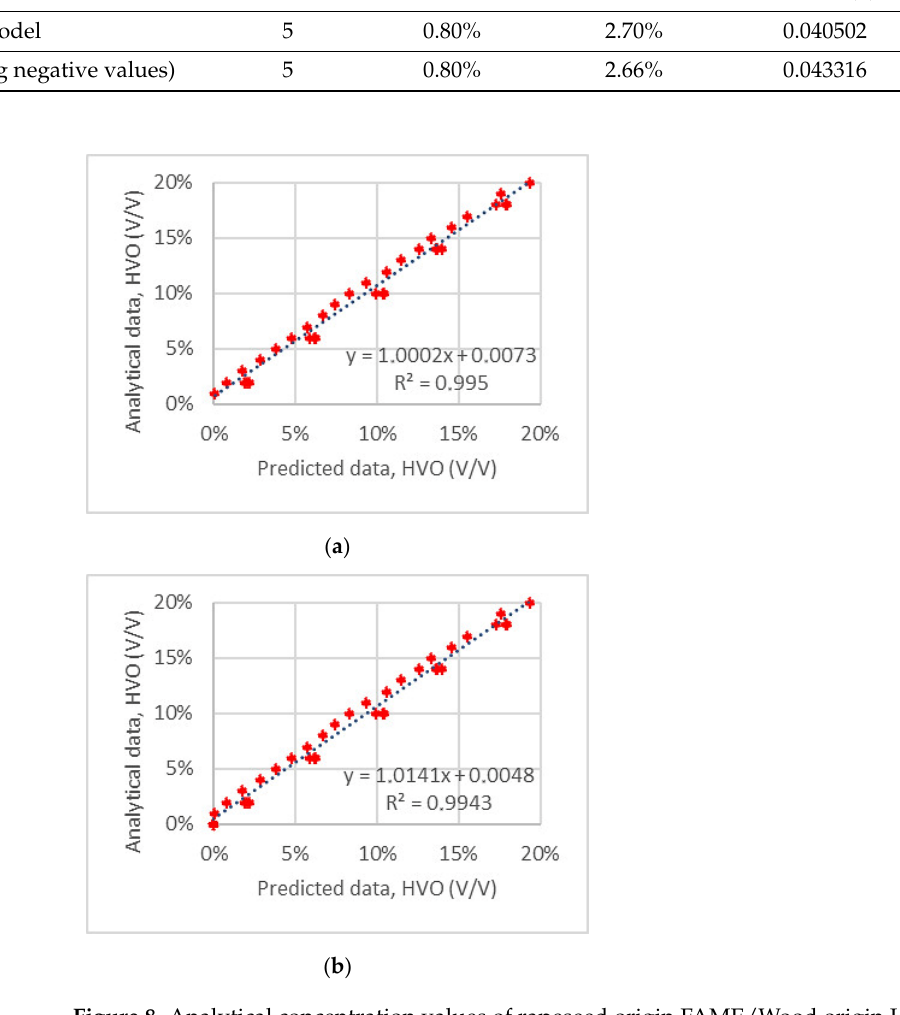
Table 5. HVO quantification PLS model results; all diesel blends.